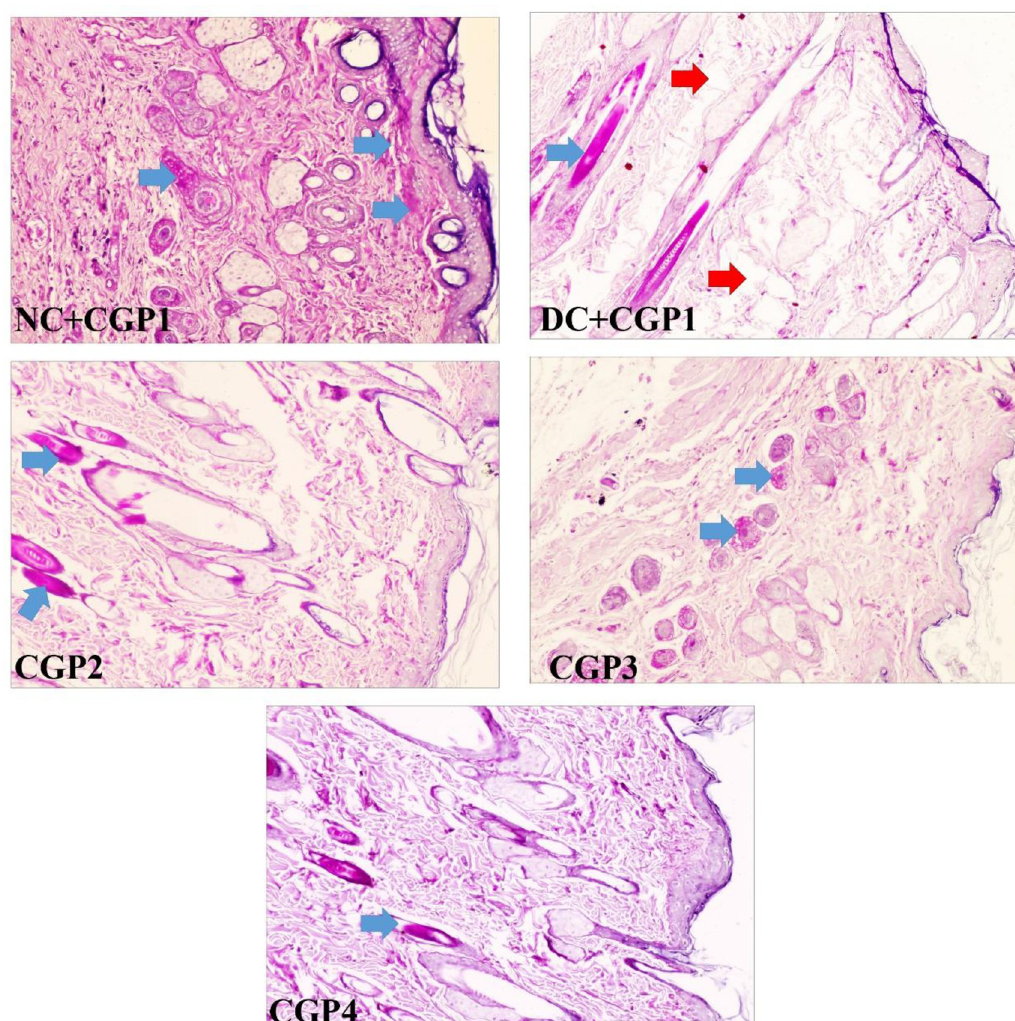
Fig 2. Effect of GC-AgNP CGPs dressing on histopathology in diabetic rats. Periodic Acid Schiff’s’ staining (PAS) rats wound tissue showing the cellular changes (glycogen & nuclear changes). Red arrows point towards the histopathological changes and blue arrow point towards glycogen distribution. NC+CGP1: Normal control dressed with blank cotton gauze; DC+CGP1: Diabetic control rats dressed with blank cotton gauze; CGP2: Diabetic rats dressed with 13.06 μ M gallocatechin and silver nanoparticle (GC-AgNP) impregnated cotton gauze patches (DC+ 13.06 μ M CGP2); CGP3: Diabetic rats dressed with 26.12 μ M gallocatechin and silver nanoparticle (GC-AgNP) impregnated cotton gauze patches (DC+ 26.12 μ M CGP3). CGP4: Diabetic rats dressed with silver sulfadiazine (DC+AgS) impregnated cotton gauze patches. Scale bar = 100 μ m. Images are taken at 400x magnification.